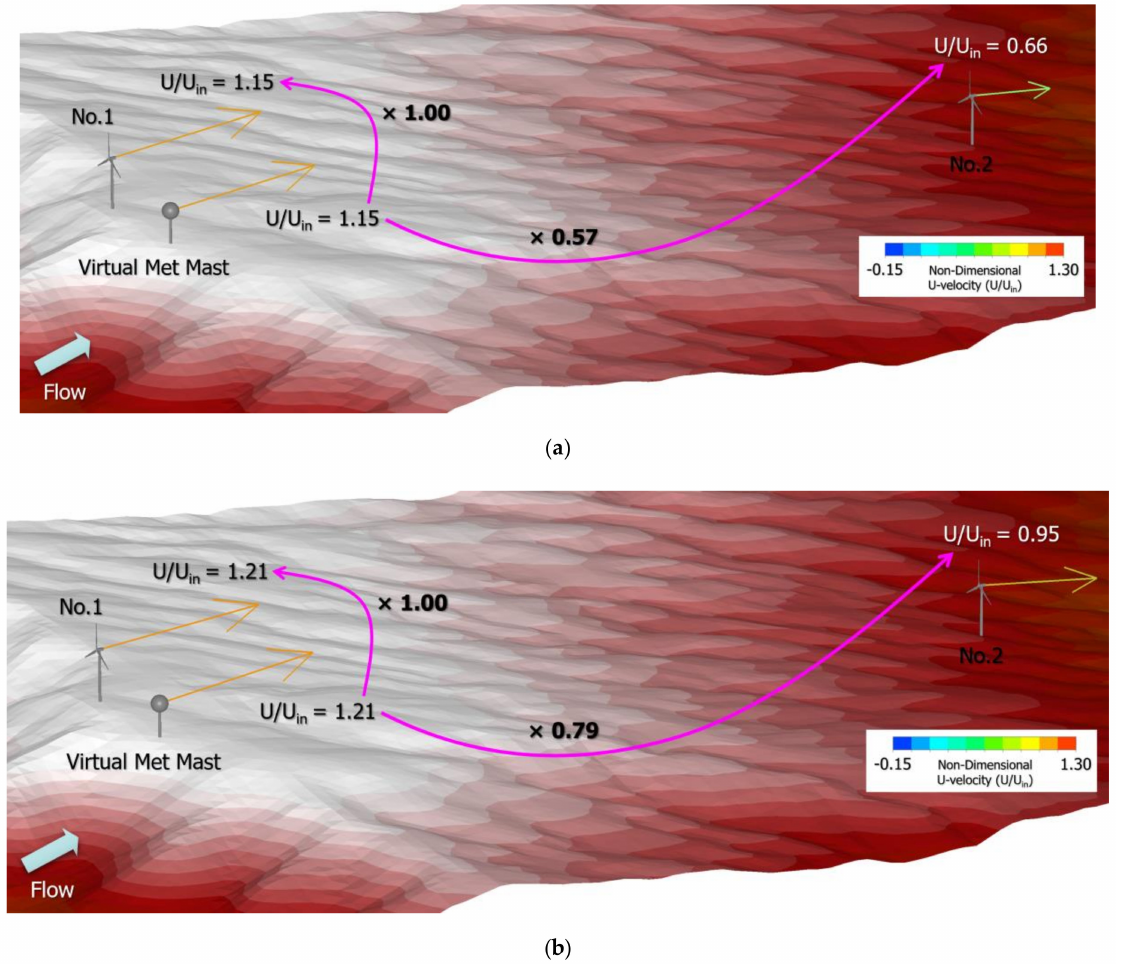
Figure 24. Wind speed-up ratio of the wind turbine hub height (78 m) with a virtual met mast with a height of 50 m. ( a ) Neutrally stratified condition (Ri = 0.0); ( b ) Stable stratified condition (Ri = + 1.0).